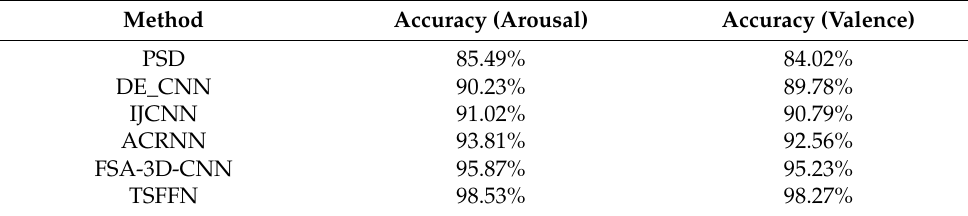
Table 8. Performance comparison of different